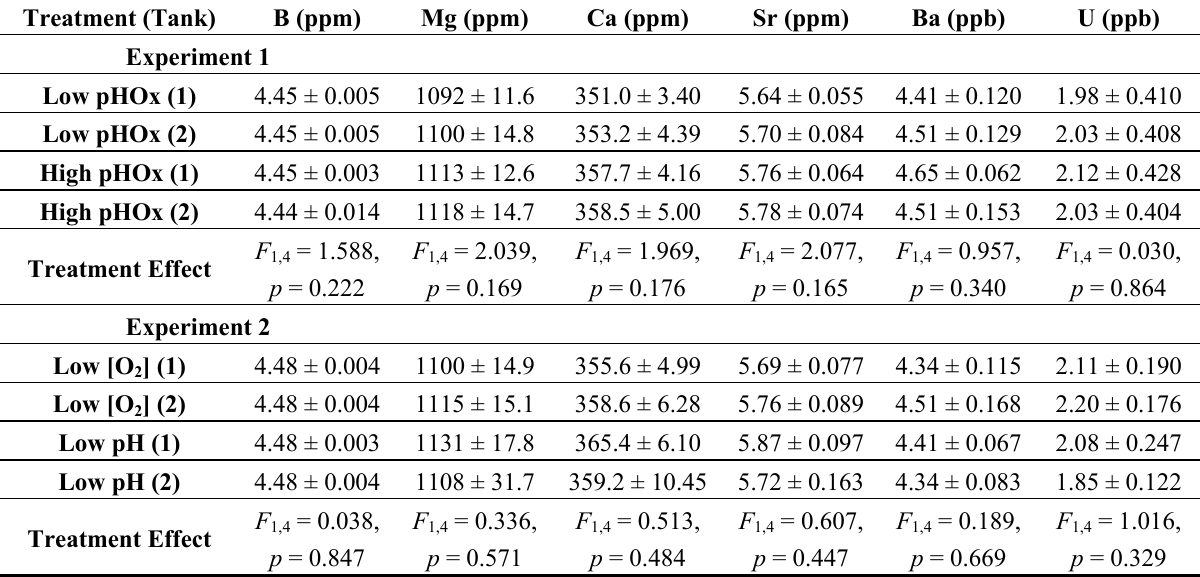
Table A1. Seawater elemental concentrations measured in the laboratory experiments. Values are the average ± one standard error for samples taken once a week in each treatment ( n = 5). No treatment effects were found for either Experiments 1 or